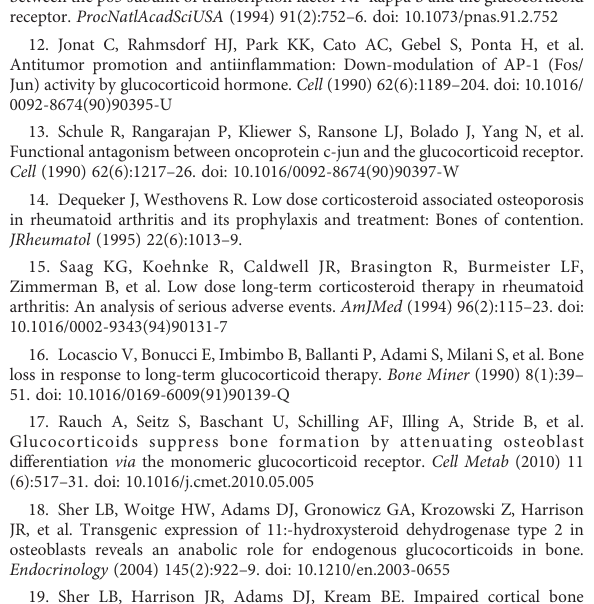
SUPPLEMENTARY FIGURE 1 Characterization of GR KO MSCs. (A) Bright fi eld images showing morphology of puri fi ed MSCs. (B) qRT-PCR showing the absence of GR mRNA in GR KO cells. Inset: Agarose gel image showing qPCR products. (C) FACS analysis showing percentages of CD45, CD11b, and Sca-1 positive cell populations in puri fi ed GR- fl ox (top panel) and GR KO (bottom panel) MSCs. (D) Western blot showing the absence of GR protein in GR KO cells. (E) Immunostaing showing nuclear translocation of GR protein in response to dexamethason (Dex) stimulation (100nM for